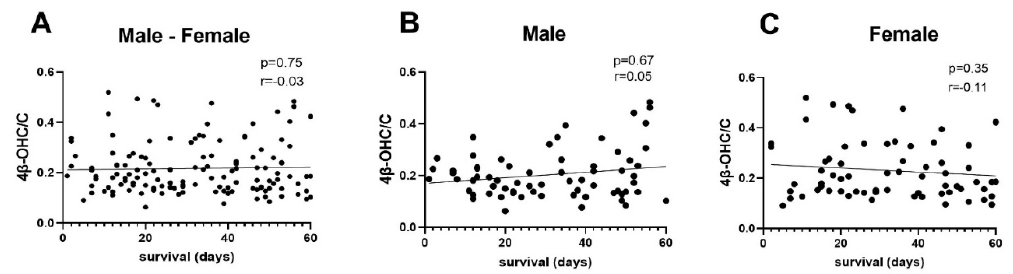
Figure 2. Correlation between 4 β -hydroxycholesterol/cholesterol ratio (4 β -OHC/C) and survival time measured in days in ( A ) all patients ( n = 137) ( B ) males ( n = 69), and ( C ) females ( n = 68). Statistical analysis was performed using Spearman’s rank test. r = Spearman’s r.